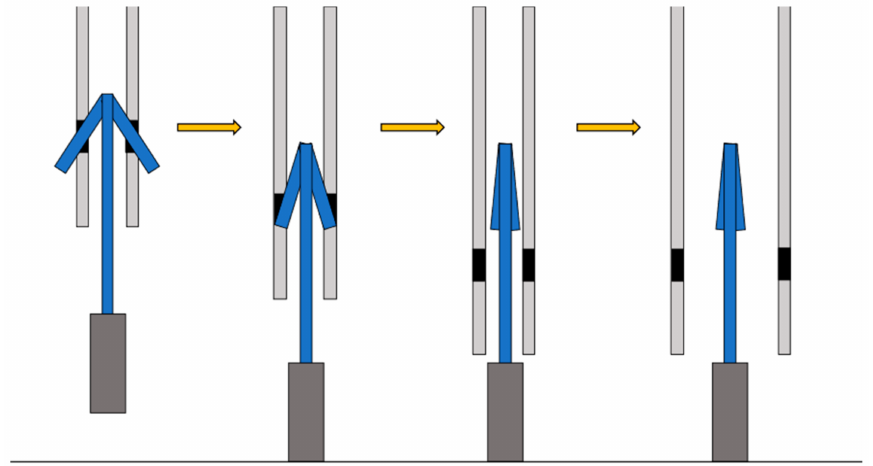
Figure 14. Deformation caused by the impact of falling.